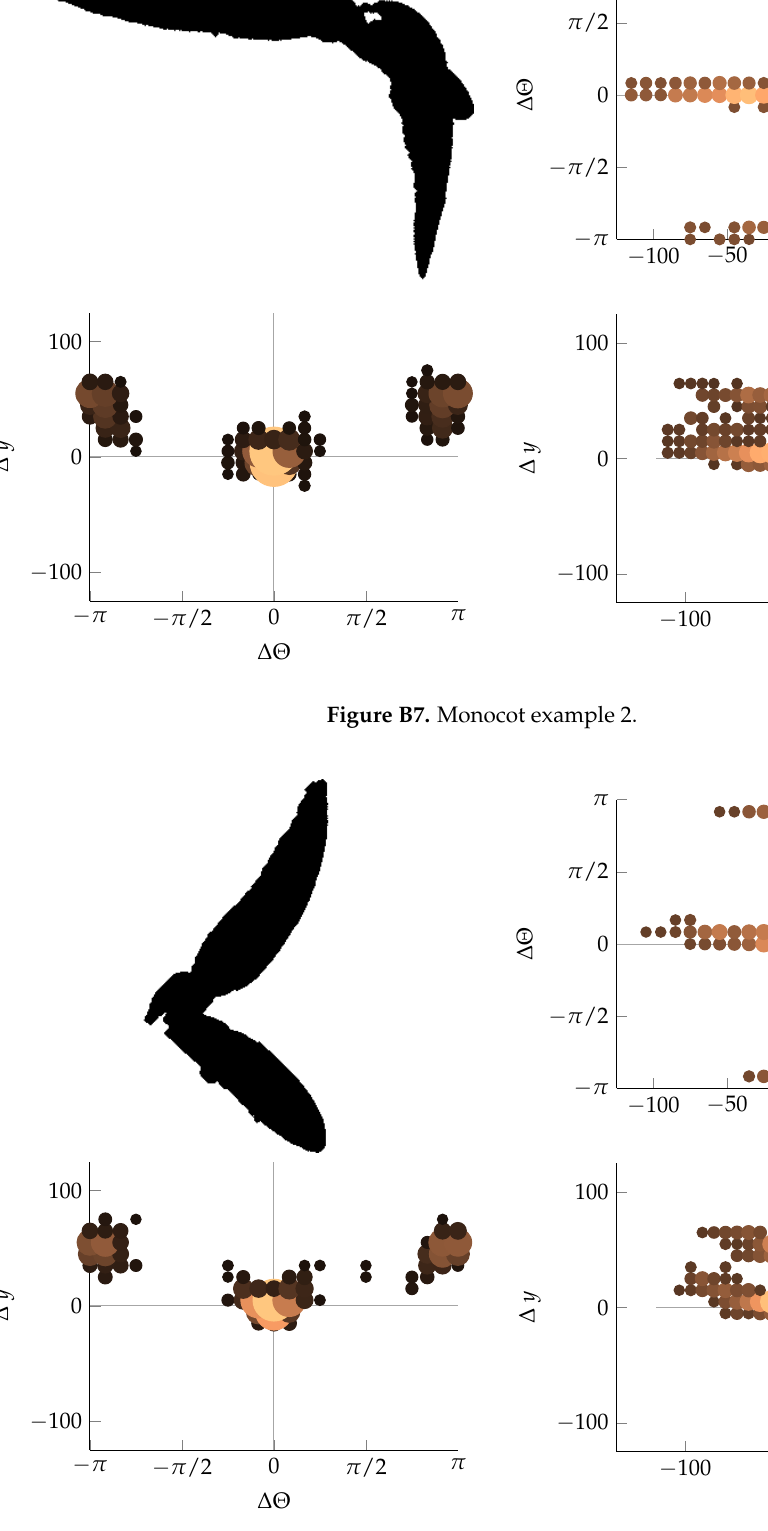
Figure B8. Monocot example